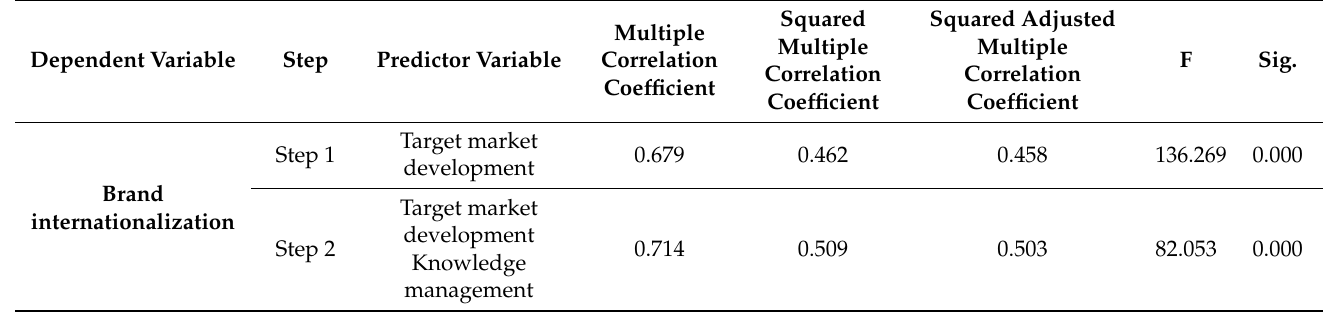
Table 9. Multiple coefficients of correlation between applying business intelligence dimensions and brand internationalization in large industrial